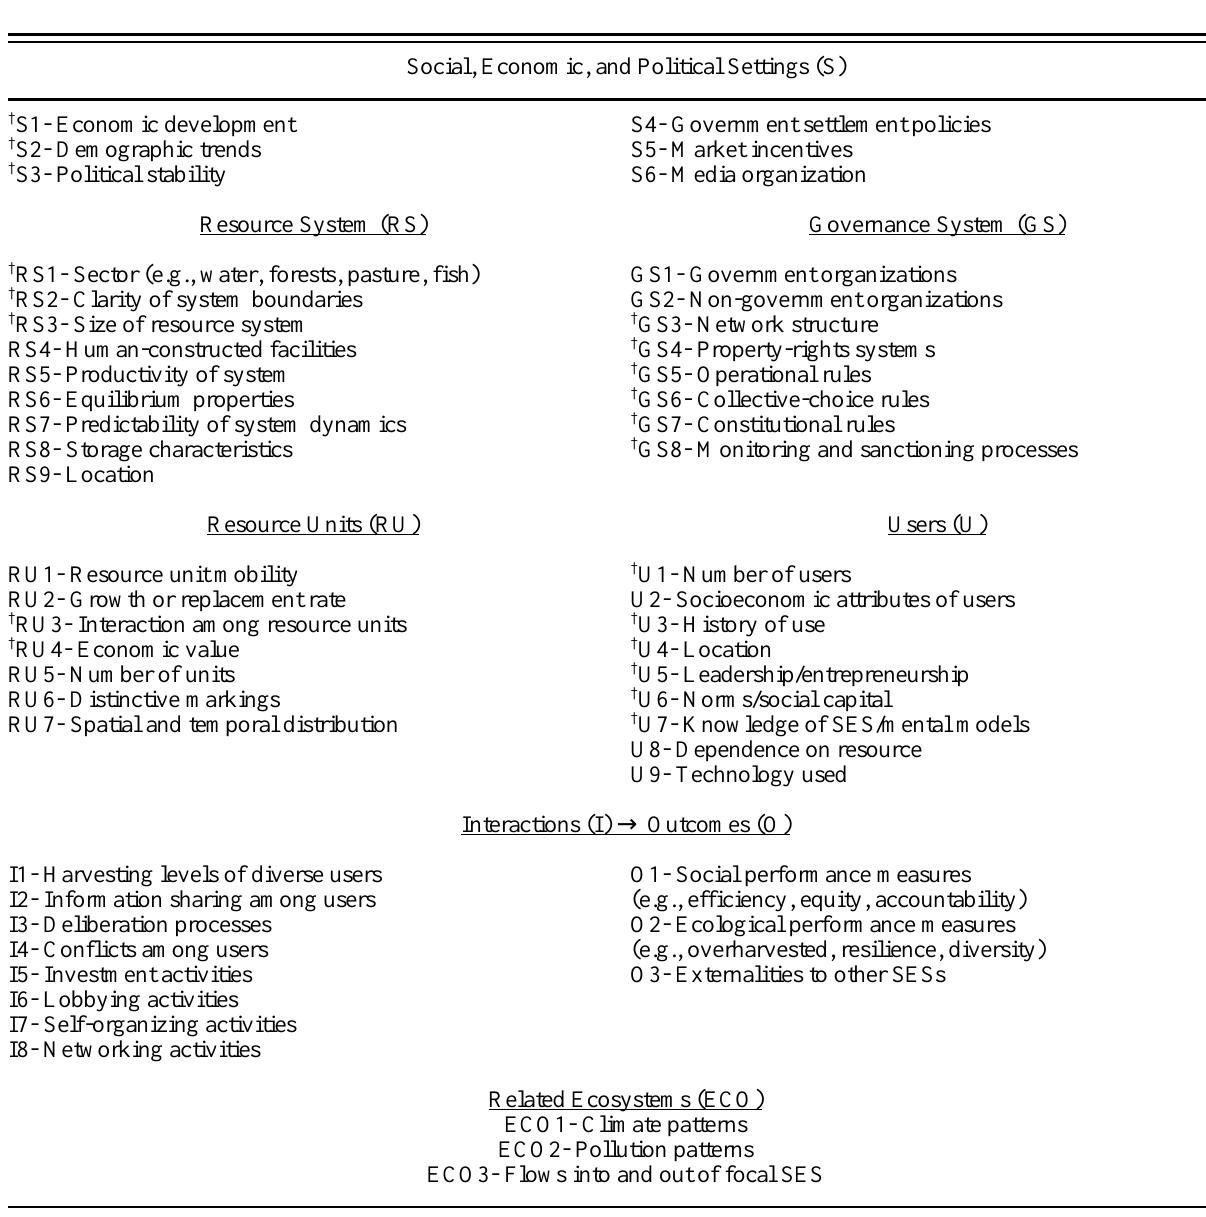
Table 1 . Factors that contribute to community responses to disturbances. Adapted from Ostrom